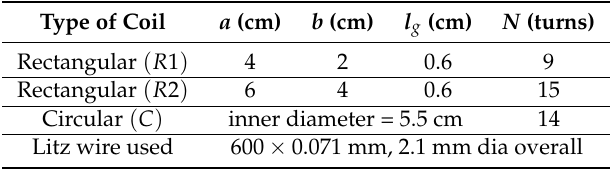
Table 1. Properties of the compared circular and rectangular